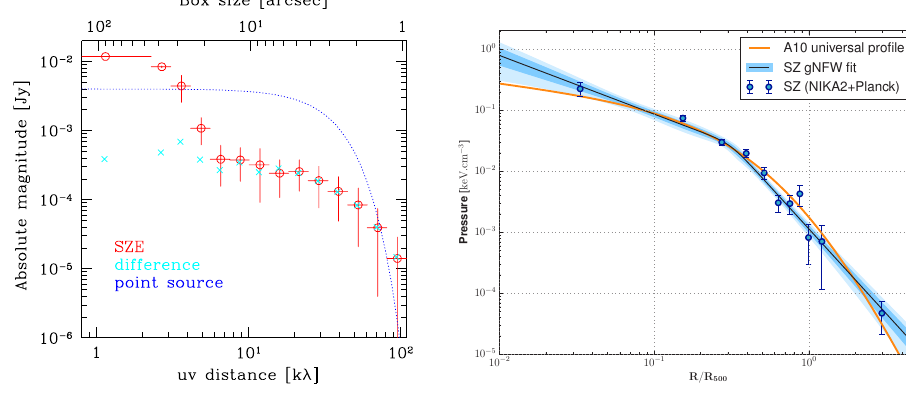
Figure 3. Left: SZ e ff ect signature of RX J1347.5–1145 at 92GHz imaged by ALMA after deconvolu- tion as shown by red open circles with their associated error bars [22], a Gaussian source of 4mJy / beam with a size of 3.2 (cid:28)(cid:28) (FWHM) is also displayed in dashed blue. Top x-axis shows that going up to 20 to 40 (cid:28)(cid:28) scales is suitable to retrieve the SZ signature in the Fourier domain. Right: Pressure profile of PSZ2 G144.83 + 25.11 (in blue) constrained by NIKA2 (blue circles) and Planck [23] which is compared to the Universal Pressure Profile [24] with an orange line. NIKA2 data and associated fit suggest a departure from the Universal Profile at small and a dust Figure 2. Left: Redshift-dependent flux density of a galaxy with fixed dust mass of 10 8 M (cid:30) emissivity index of β = 1.5 from Staguhn et al. [16]. Right: SED of a Herschel selected gravitational lens at z 3. The NOEMA part of the SED is measured with an accuracy better than 10% in about ∼ one-hour on-source (Berta et al., in prep.).